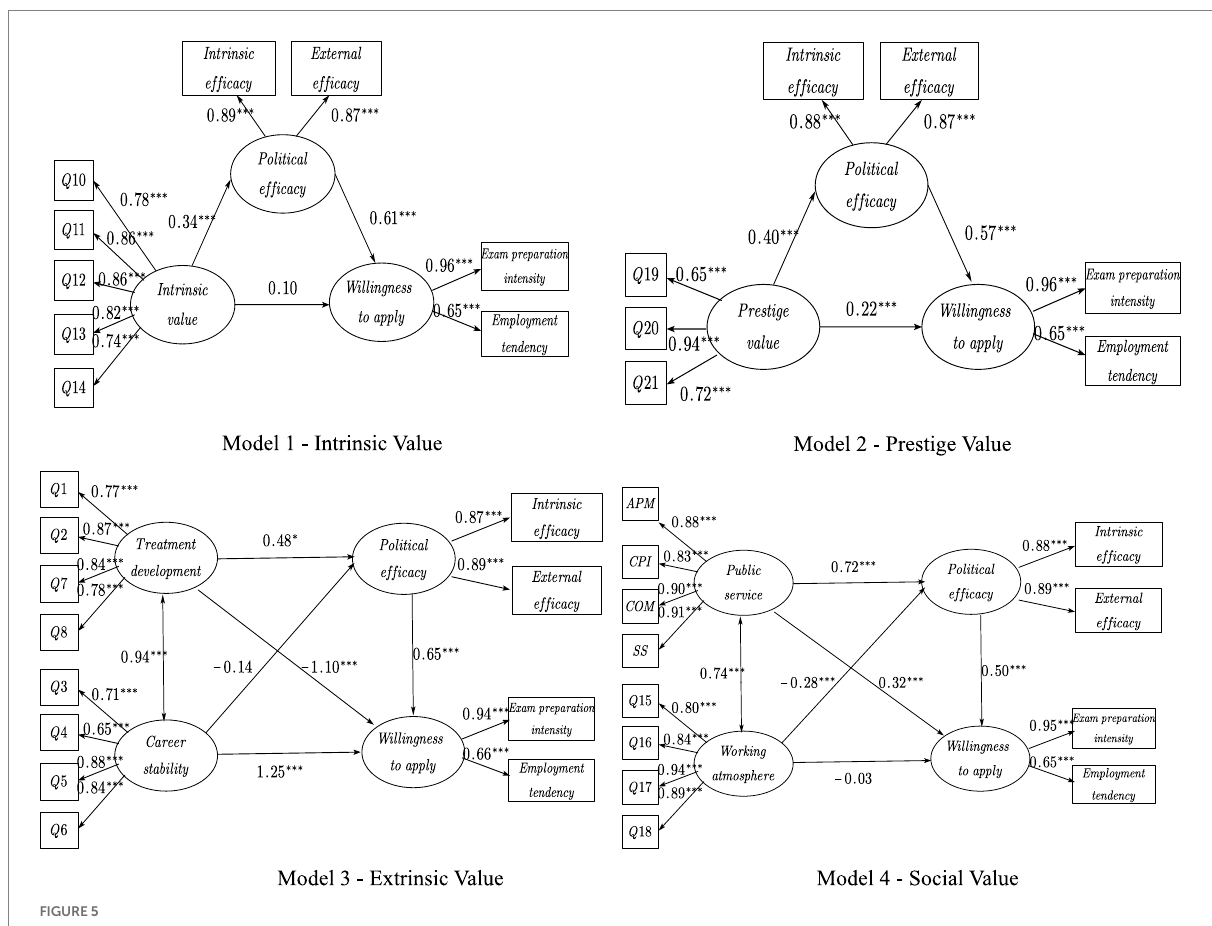
FIGURE 5 Four models of structural equations. * means p < 0.05, ** means p < 0.01, *** means p < 0.001.